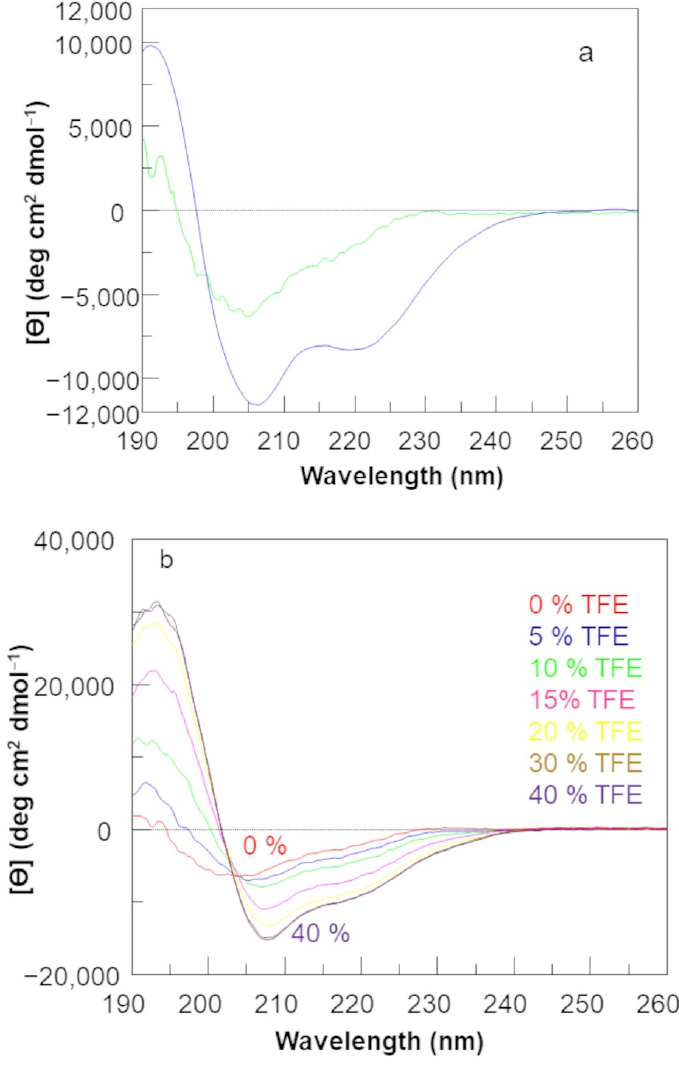
Figure 1. ( a ) Far-UV circular dichroism spectrum of D − QK (green line) and QK (blue line) recorded at 20 °C in 5 mM phosphate buffer, pH 7.0. ( b ) Trifluoroethanol titration of peptide D-QK. CD spectra were recorded at 20 °C in water/TFE mixture. TFE percentage was increased from 0% to 40%. Spectra are reported as mean residue ellipticity.